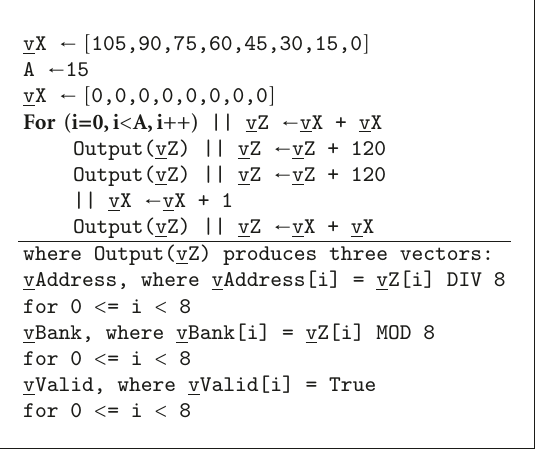
Algorithm 2: iVAG pseudo code for the 24 × 15 matrix inter- leaving function